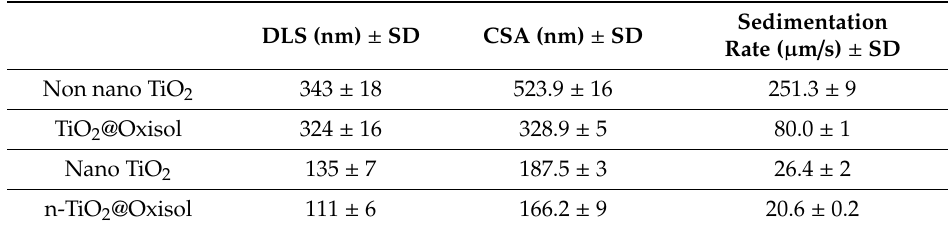
Table 4. Particle size values detected via DLS and CSA (first and second columns) and sedimentation rate (last